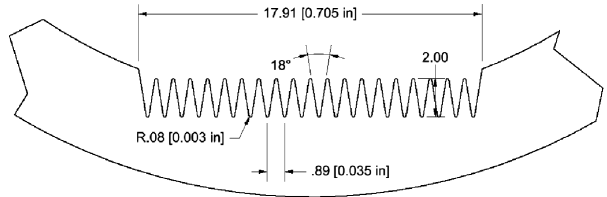
FIG. 5. Schematic cross section of bottom wall showing the dimensions of the grooves used to suppress EC buildup in the dipole